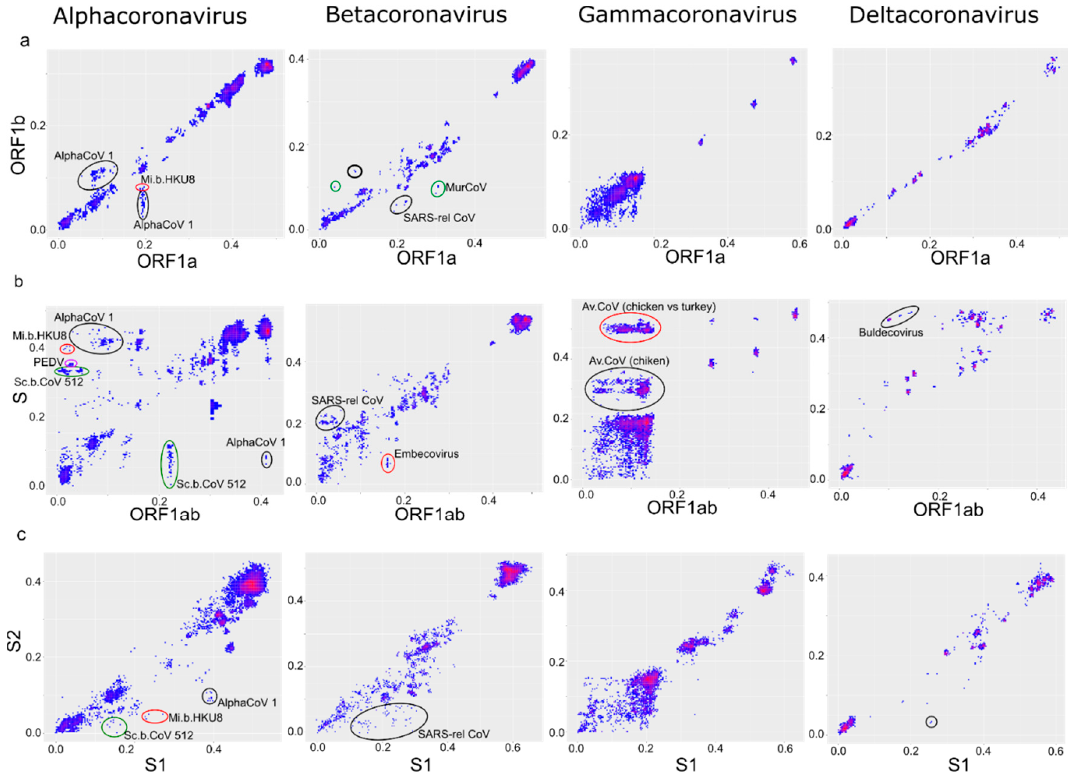
Figure 5. Recombination is more common between ORF1 and spike than within ORF1. Correspondence of pairwise nucleotide distances (PDC plots) between ORF1a and ORF1b ( a ), ORF1ab and spike ( b ), and S1 and S2 regions of spike ( c ). AlphaCoV 1, Alphacoronavirus 1 ; Mi.b.HKU8, Miniopterus bat coronavirus HKU 8 , Sc.b.CoV 512, Scotophilus bat coronavirus 512 ; SARS-rel. CoV, SARS-related coronavirus ; MurCoV, Murine coronavirus ; Av.CoV, Avian coronavirus. Points that correspond to virus pairs that underwent recombination and are discussed in the text are marked with circles.